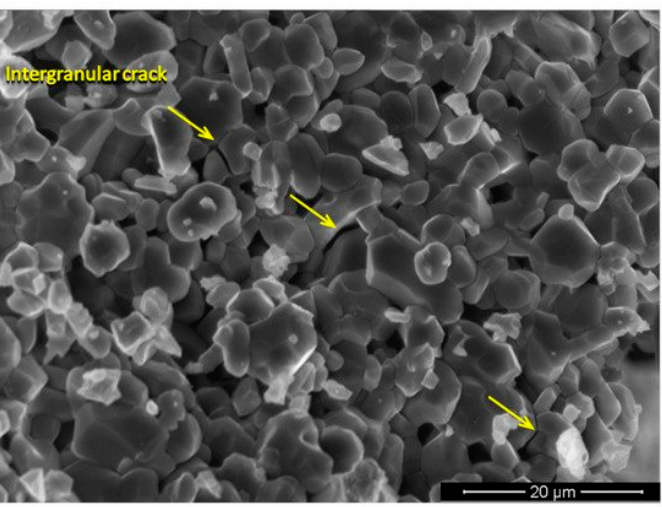
Figure 17. SEM image of ceramic intergranular fragmentation after ballistic test. (Adapted with copyright permission from Da Luz et al. [134]).